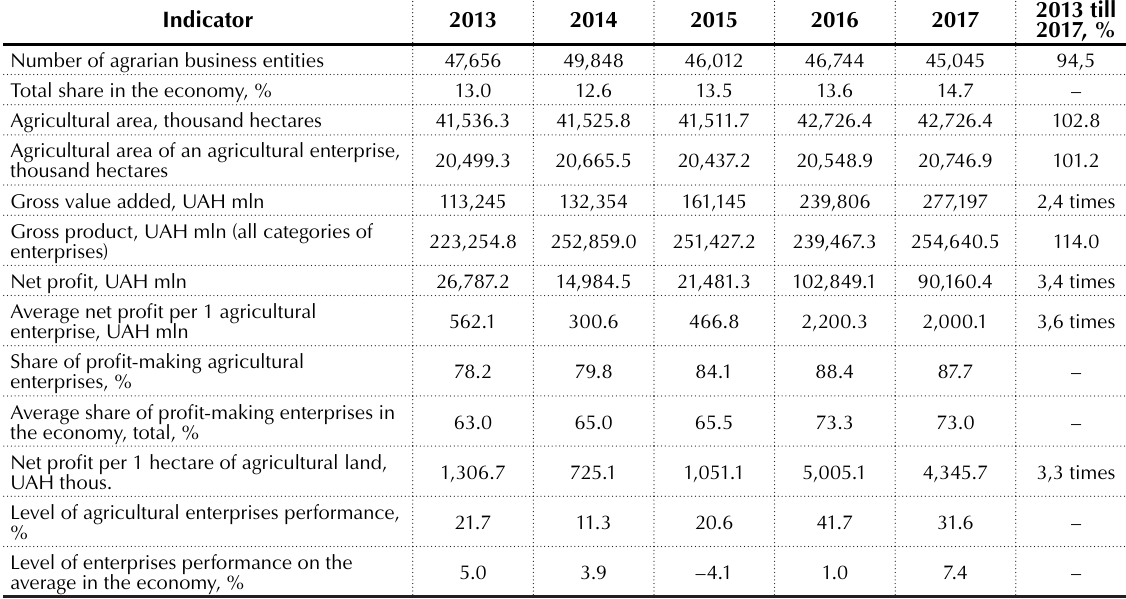
Table 1. Indicators of land use efficiency in the agrarian sector of Ukraine for the period 2013–2017